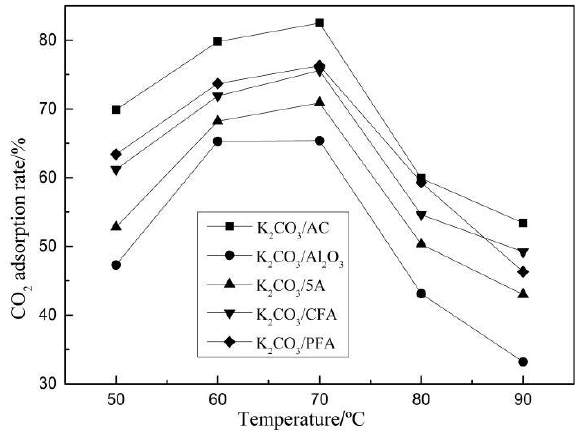
Figure 4. CO 2 adsorption rate at different temperatures.